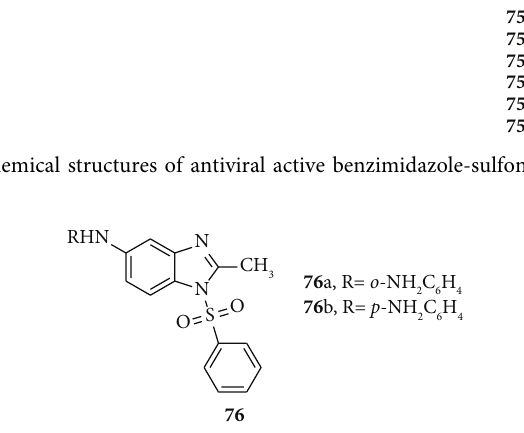
Figure 6: Chemical structures of antiproliferative active benzimidazole-sulfonyl derivatives.